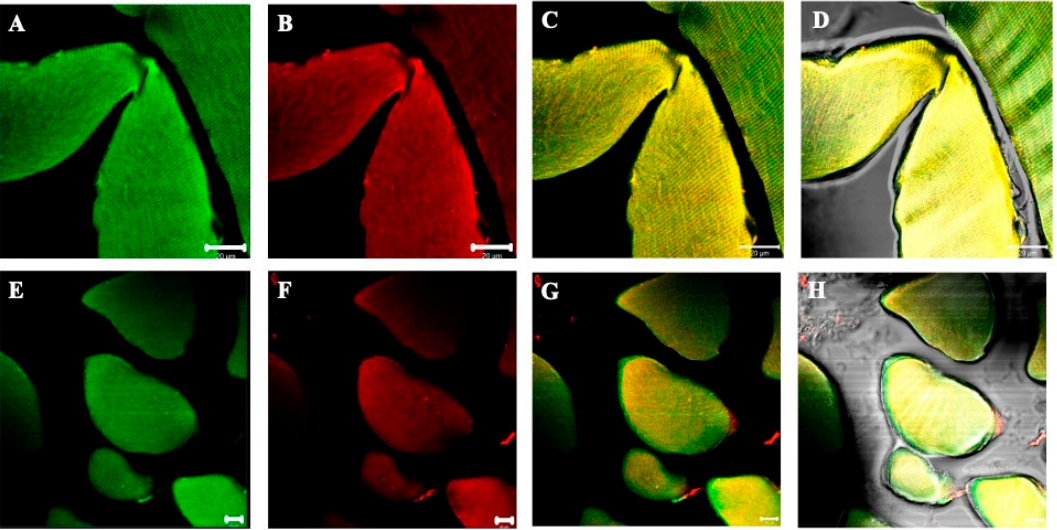
Figure 1. Compound panel of double immunofluorescence reaction between alpha-SG (green channel) and beta-SG (red channel) ( A – D ) and between gamma- and delta-SG ( E – H ) performed on sternocleidomastoid of high-ranking baboons. Results show that both alpha- and beta-SG are expressed along all observed muscle fibers. The transmitted light shows that all the fibers in the microscopic field are positive for sarcoglycans ( D , H ). The yellow fluorescence arises from the merge between green and red fluorescence and corresponds to protein colocalization. The same data have been found for all the SG isoforms.